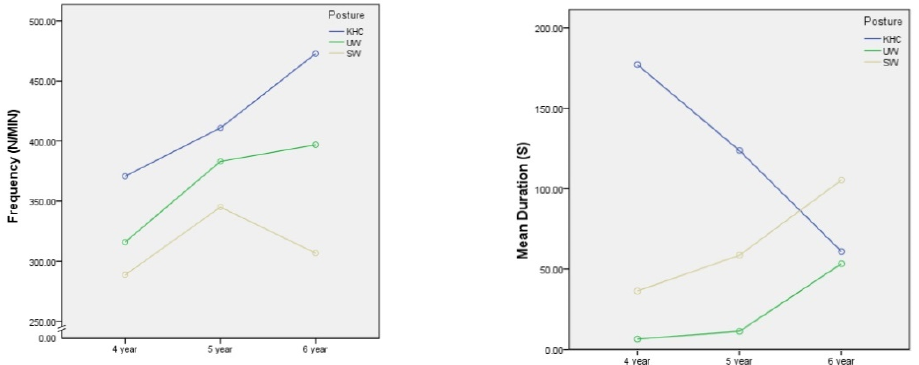
Figure 10. The estimated marginal mean of joints exceeding the threshold. UW—upright walking; SW—stoop walking; KHC—knee and hand crawling.